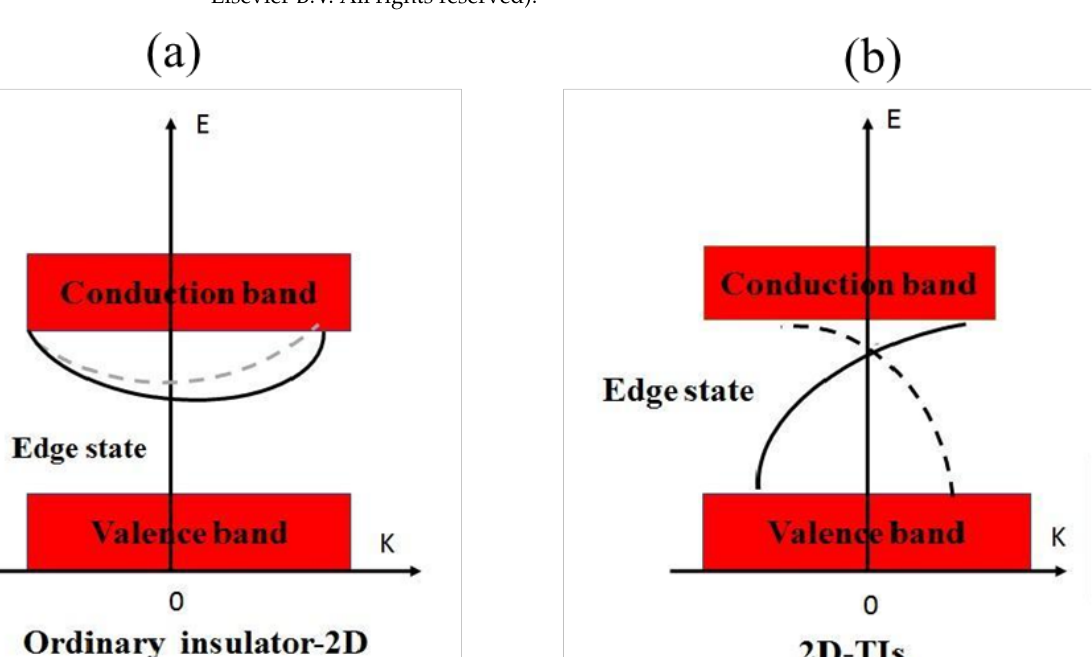
Figure 3. ( a ) Monolayer 1T’ MM’X 4 compounds are shown in top. The a and b represent the lattice parameter of the unit cell in x and y direction respectively. ( b ) side views where M is Nb, Ta or V, is Ir or Co, and X is Te. ( c ) The BZs for 1 1 1T-MX 2 are indicated by solid lines. The 1 2 (1T’-MX 2 ) and 1 4 (MM’X 4 ) smallest repeated cell dashed lines enclosing their Brillouin Zones are cover in grey and blue, colour. The high symmetry points of 2D TMDs are marked with stars (*) and primes (’), respectively [53] (© 2021 The Physical Society of the Republic of China (Taiwan). Published by Elsevier B.V. All rights reserved).